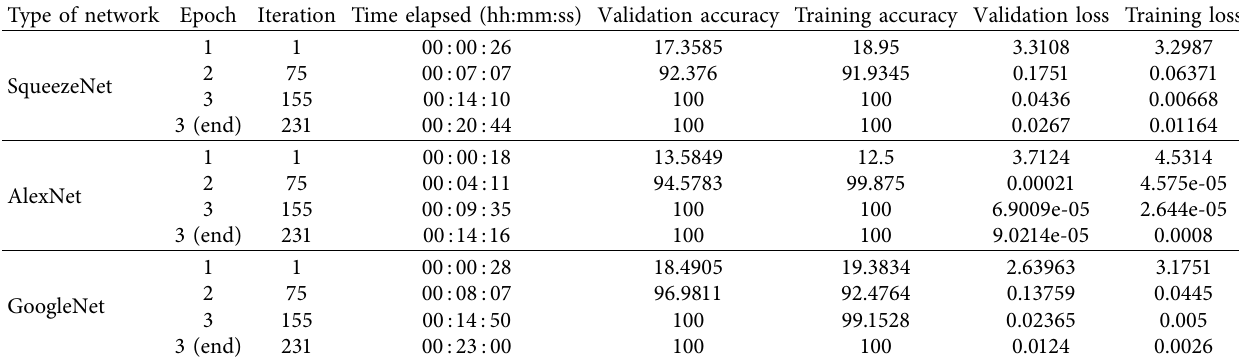
Table 4: I ntermediate results for SqueezeNet, AlexNet, and GoogleNet.